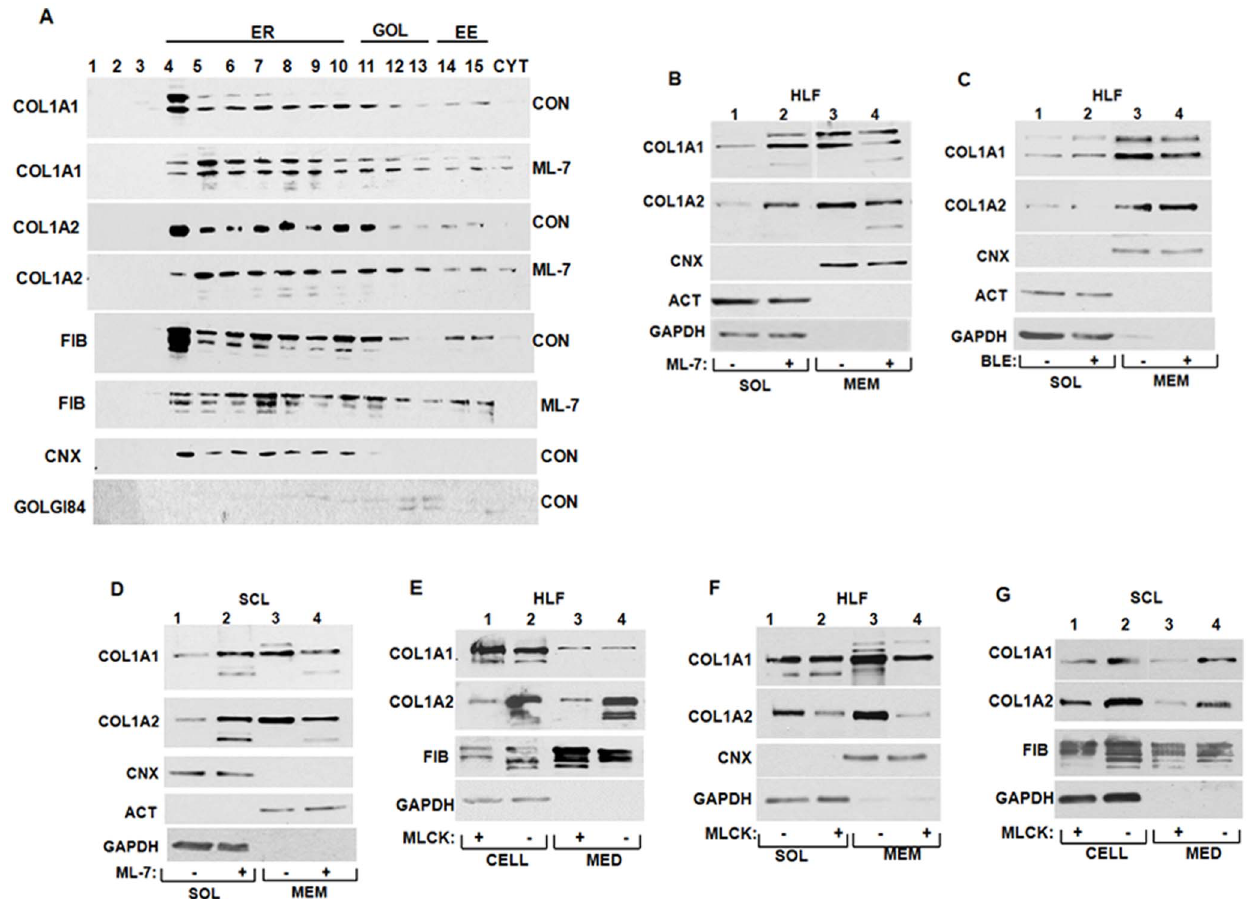
Figure 5. Disruption nonmuscle myosin results in cytosolic accumulation of collagen polypeptides. A. Distribution of collagen polypeptides in the secretory pathway compartments. Extracts of control and ML-7 treated HLFs were fractionated by density gradient centrifugation into fractions containing endoplasmic reticulum (ER), Golgi (GOL), early endosomes (EE) or cytosol (CYT) and the fractions were analyzed by western blot for presence of collagen a 1(I) (COL1A1), collagen a 2(I) (COL1A2) and fibronectin (FIB) polypeptides. Calnexin (CNX) was analyzed as a marker of the ER and golgin 84 (GOLGI84) as a marker of the Golgi complex. B. Cytosolic accumulation of collagen polypeptides after disruption of nonmuscle myosin in HLF. HLF were treated with ML-7 and fractionated into cytosolic (SOL, lanes 1 and 2) and membrane (MEM, lanes 3 and 4) fractions. The fractions were analyzed for collagen a 1(I) (COL1A1), collagen a 2(I) (COL1A2) polypeptides by western blot. Calnexin (CNX) was analyzed as a marker of membrane fraction and actin (ACT) and GAPDH as a markers of cytosolic fraction. C. Inhibition of the motor function of nonmuscle myosin has little effect on cytosolic accumulation of collagen polypeptides. Experiment as in B, except HLFs were treated with blebbistatin. D. Cytosolic accumulation of collagen polypeptides after disruption of nonmuscle myosin in scleroderma fibroblasts. Experiment as in B, except human scleroderma fibroblasts were used. E. Inhibition of collagen expression by DN-MLCK. DN-MLCK was overexpressed in HLFs and collagen a 1(I) (COL1A1) and a 2(I) (COL1A2) polypeptides were analyzed in cell extract (lanes 1 and 2) and in cellular medium (lanes 3 and 4). Loading controls; fibronectin (FIB) and GAPDH. F. Cytosolic accumulation of collagen polypeptides after disruption of nonmuscle myosin by DN-MLCK. DN-MLCK was overexpressed in HLF and cells were fractionated into cytosolic (SOL, lanes 1 and 2) and membrane (MEM, lanes 3 and 4) fractions. The fractions were analyzed for collagen a 1(I) (COL1A1) and collagen a 2(I) (COL1A2) polypeptides by western blot. Loading controls; calnexin (CNX) and GAPDH. G. Inhibition of collagen expression by DN-MLCK in scleroderma fibroblasts. DN-MLCK was overexpressed in scleroderma fibroblasts and collagen a 1(I) (COL1A1) and a 2(I) (COL1A2) polypeptides were analyzed in cell extract (lanes 1 and 2) and in cellular medium (lanes 3 and 4). Loading controls; fibronectin (FIB) and